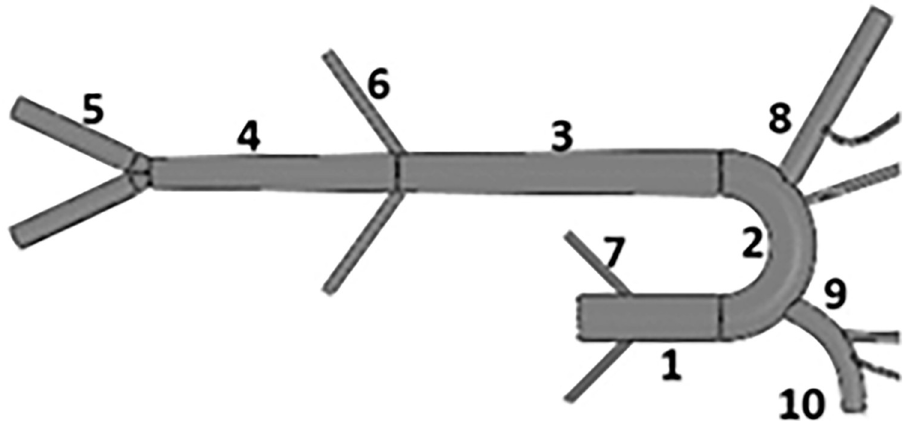
Fig 4. Schematic and segment diagram of the aorta